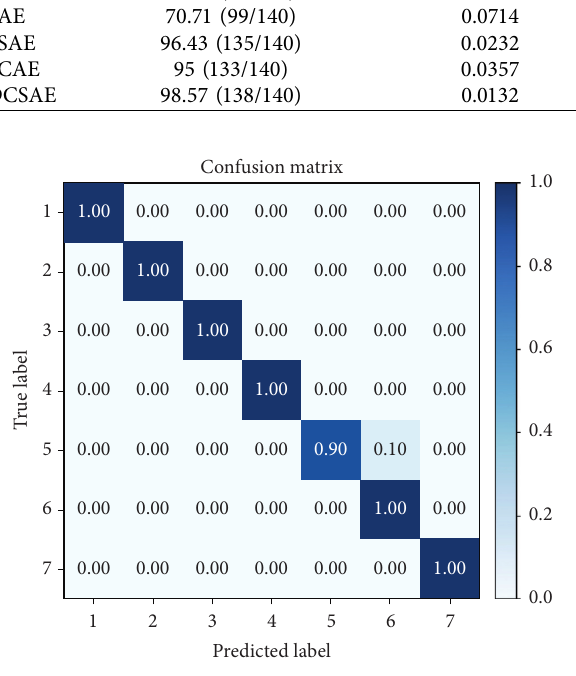
Figure 8: Confusion matrix of the DCSAE for experiment